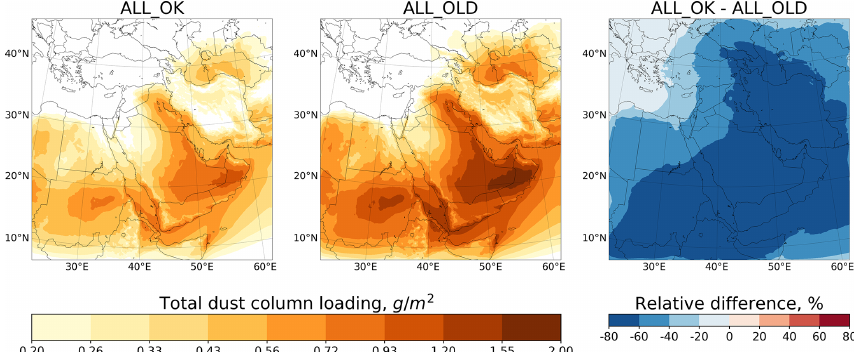
Figure 9. Averaged over the summer (June, July, August) of 2016 total dust column loadings (gm − 2 ) from the ALL_OK and ALL_OLD runs and relative difference